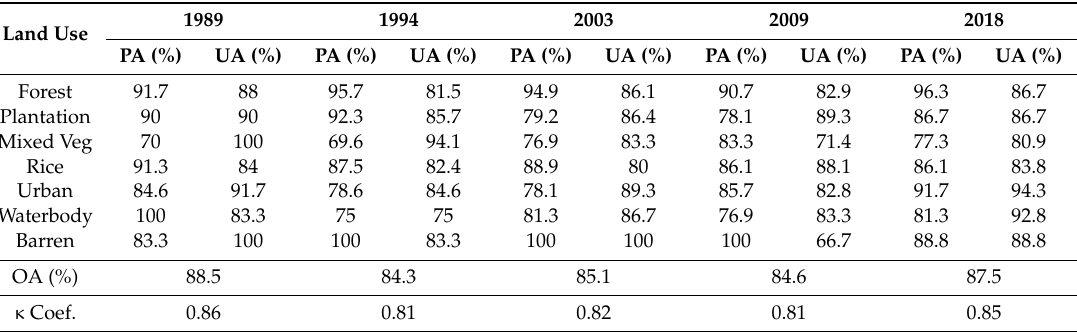
Table 3. Accuracy assessment of the land use